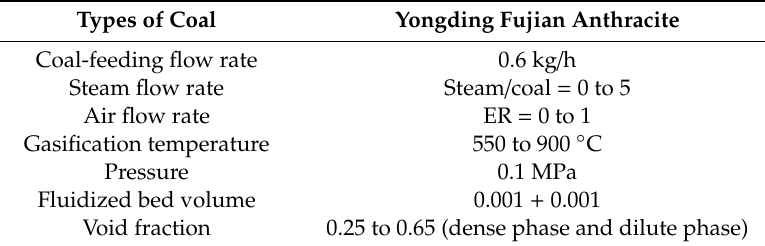
Table 4. Operation parameters used in the